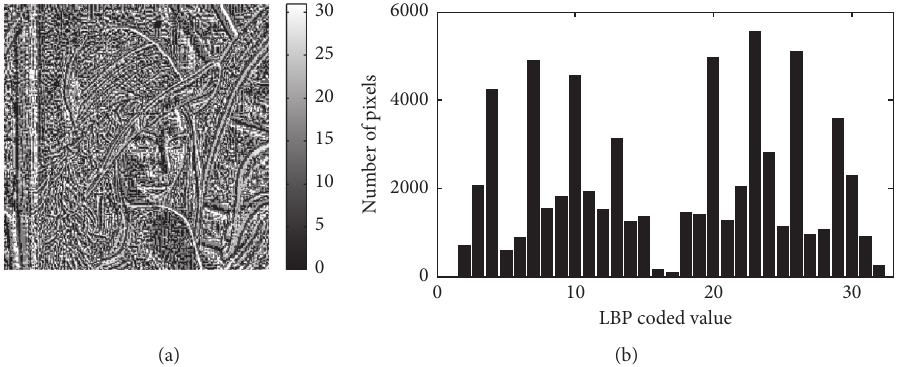
Figure 4: ILBP spectrum and statistical histogram of Lena image. (a) ILBP spectrum of Lena image. (b) ILBP statistical histogram of Lena